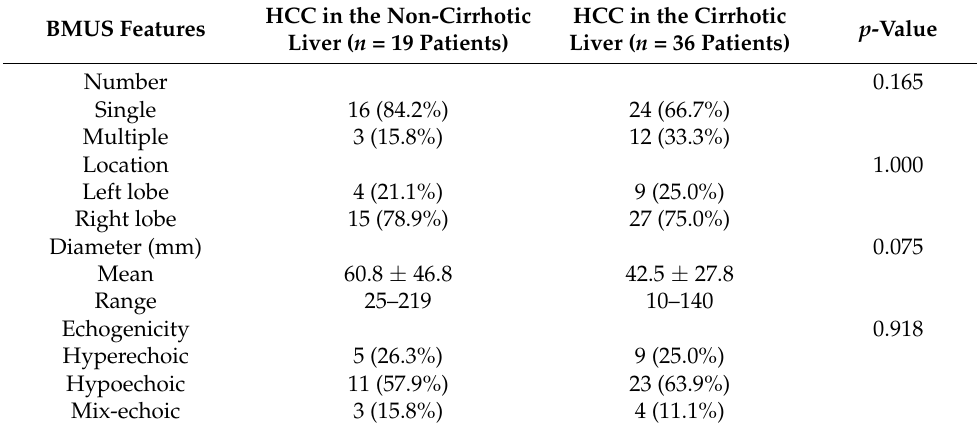
Table 2. BMUS features between two